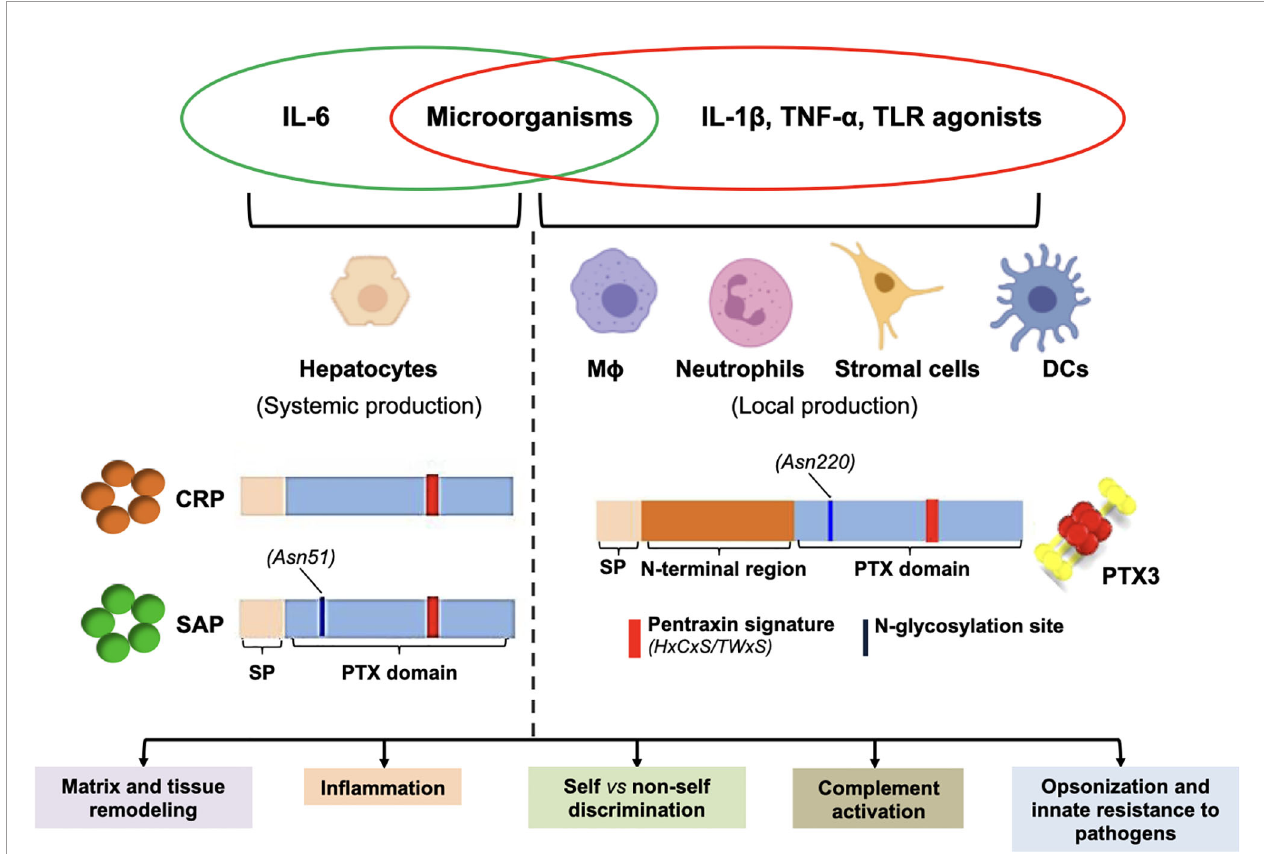
FIGURE 1 | Pentraxins at a glance. Major aspects of the biology of pentraxins are presented here that are further discussed in the main text. The short pentraxins CRP and SAP are mainly synthesized by the hepatocytes in response to IL-6 (systemic production), whereas PTX3 (prototypical long pentraxin) is locally made by a number of myeloid and stromal cells upon stimulation with pro-in fl ammatory cytokines and/or microbial moieties. All pentraxins share a family distinctive signature within the pentraxin (PTX) domain, and the long ones additionally contain an N-terminal region that is structurally unrelated to other proteins. In spite of diverse protein structure and gene regulation, these molecules have similar biological properties (summarized in the boxes), which highlights complexity and complementarity of this family of